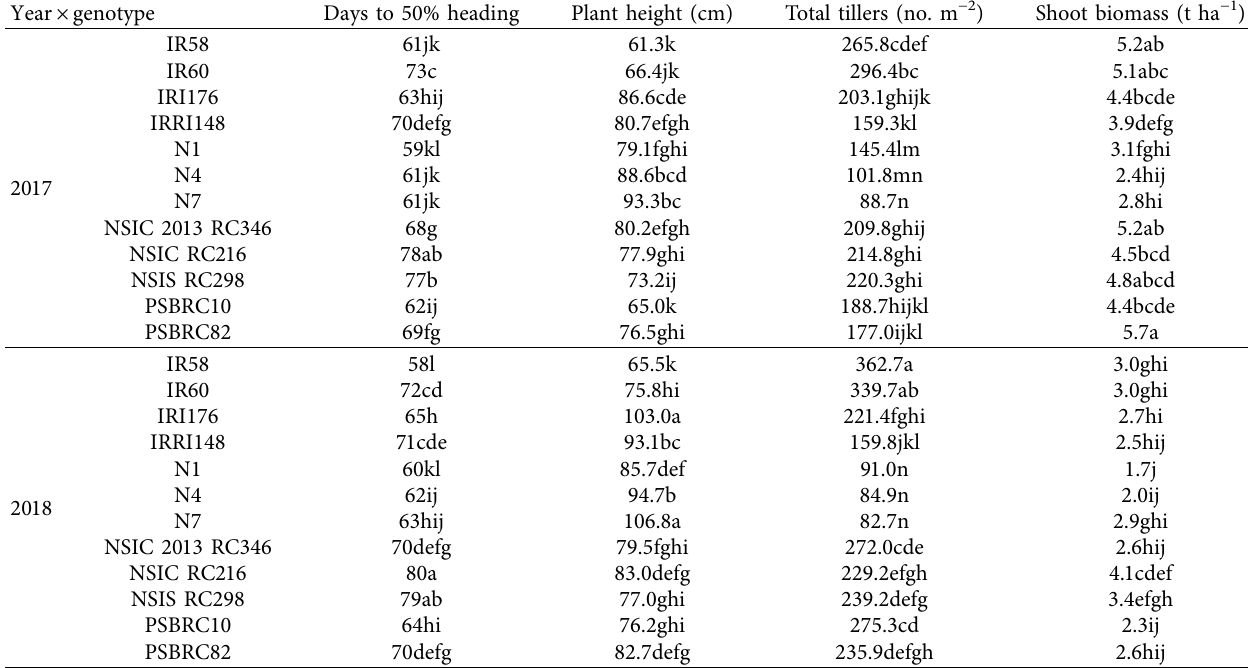
Table 2: Interactive effect of years and rice genotypes on growth characters.